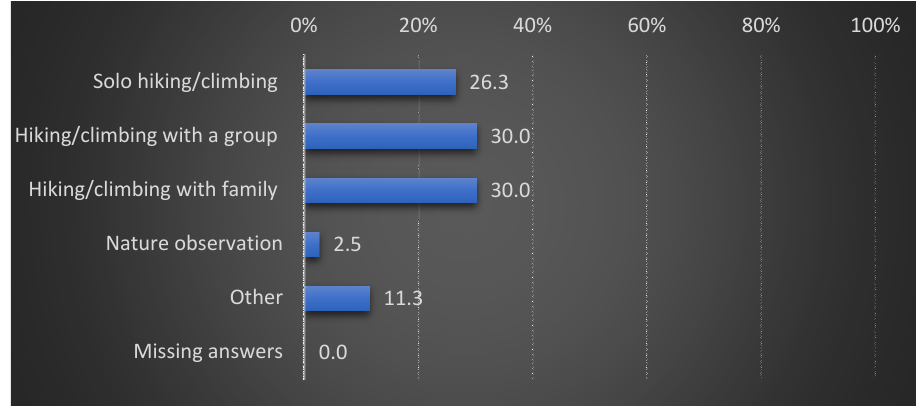
Figure 7. Types of visitors identified from the question: What is your objective for visiting the National Park this time?